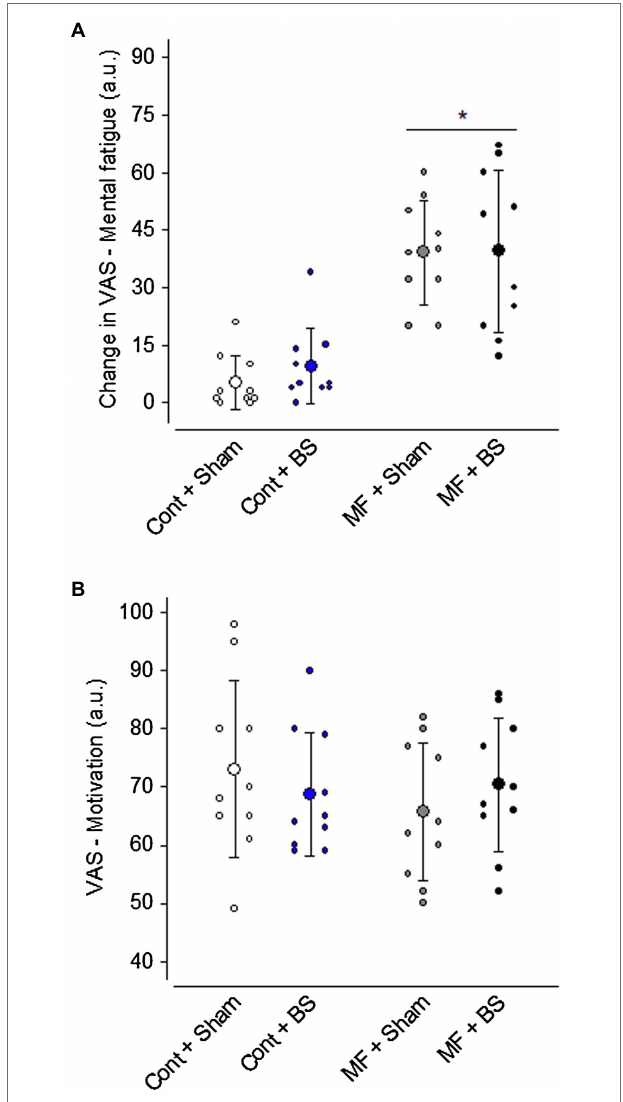
FIGURE 2 | Change in the perception of mental fatigue from pre-treatment to post-treatment (A) and motivation for the subsequent swimming task (B) . Data are expressed as mean ± standard deviation, and the scattered dots represent the individual data. * means a significant main effect of mental fatigue ( p <